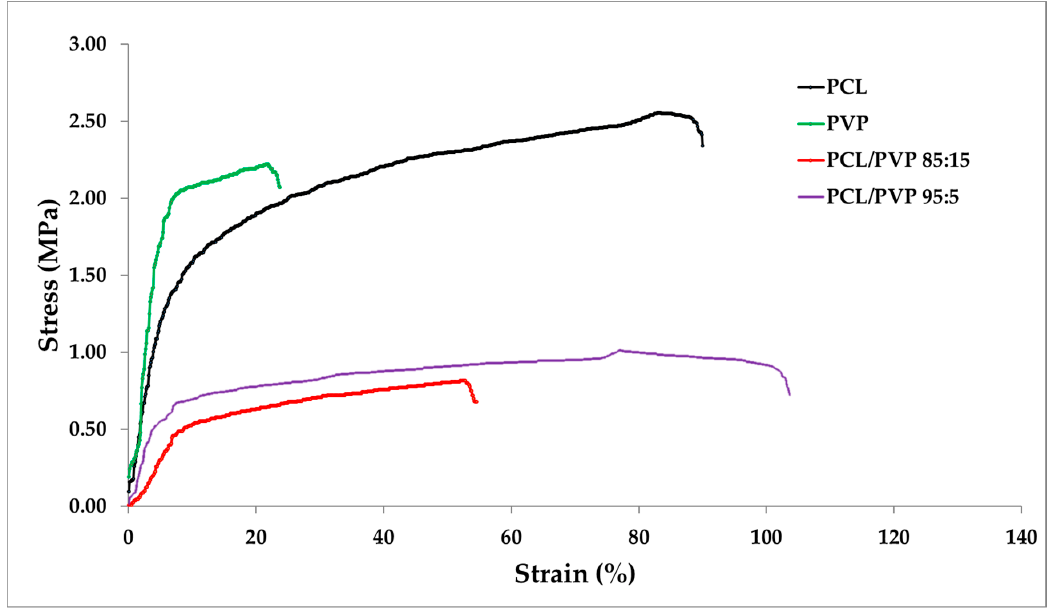
Figure 5. Typical stress–strain curves of electrospun pure PCL, PVP, PCL/PVP composite fiber mats (a selected replicate for each sample was chosen for this